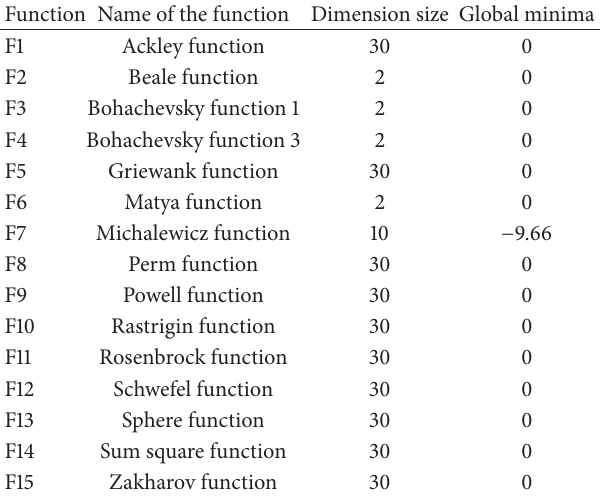
Table 1: Test functions for unconstrained global